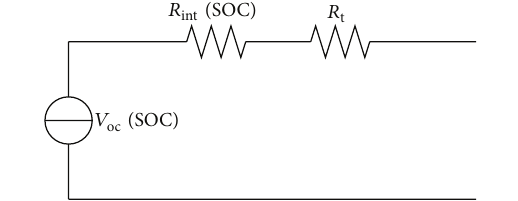
Figure 5: Motor efficiency map.